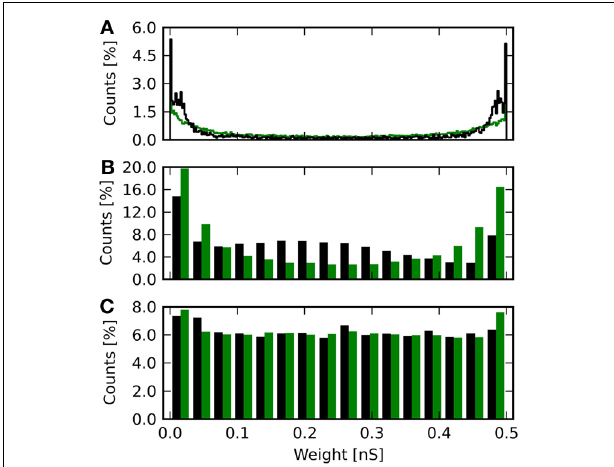
FIGURE 9 | Histogram of synaptic weights after learning with threshold readout. (A) The histogram is plotted in black for 8bit weights. The green histogram shows the result for continuous weights rounded to this resolution. (B) As in (A) , but for 4bit weights with deterministic updating. (C) Final weights for a resolution of 4bit with probabilistic updating in black. Now, the green histogram shows the final weights of the baseline simulation with added noise rounded to this resolution.